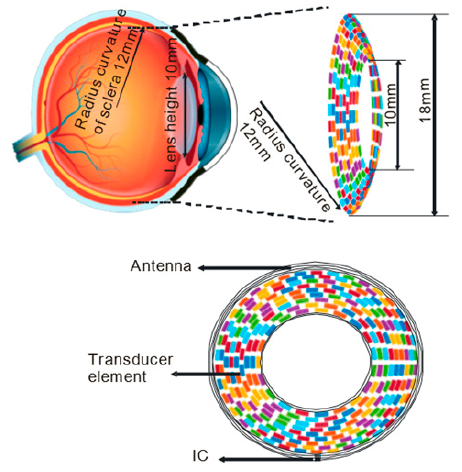
Figure 5. Design of a racing ring lens ultrasound transducer array for multifocal retinal stimulation. (Image from Yu et al., 2019 [93]).